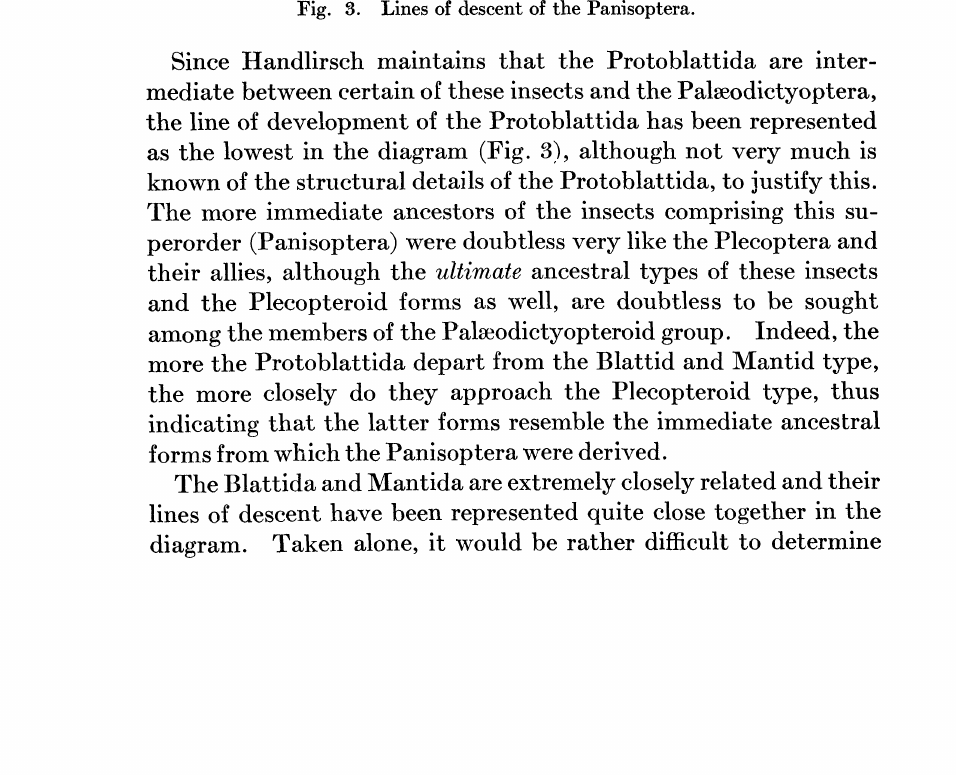
Fig. 3. Lines of descent of the